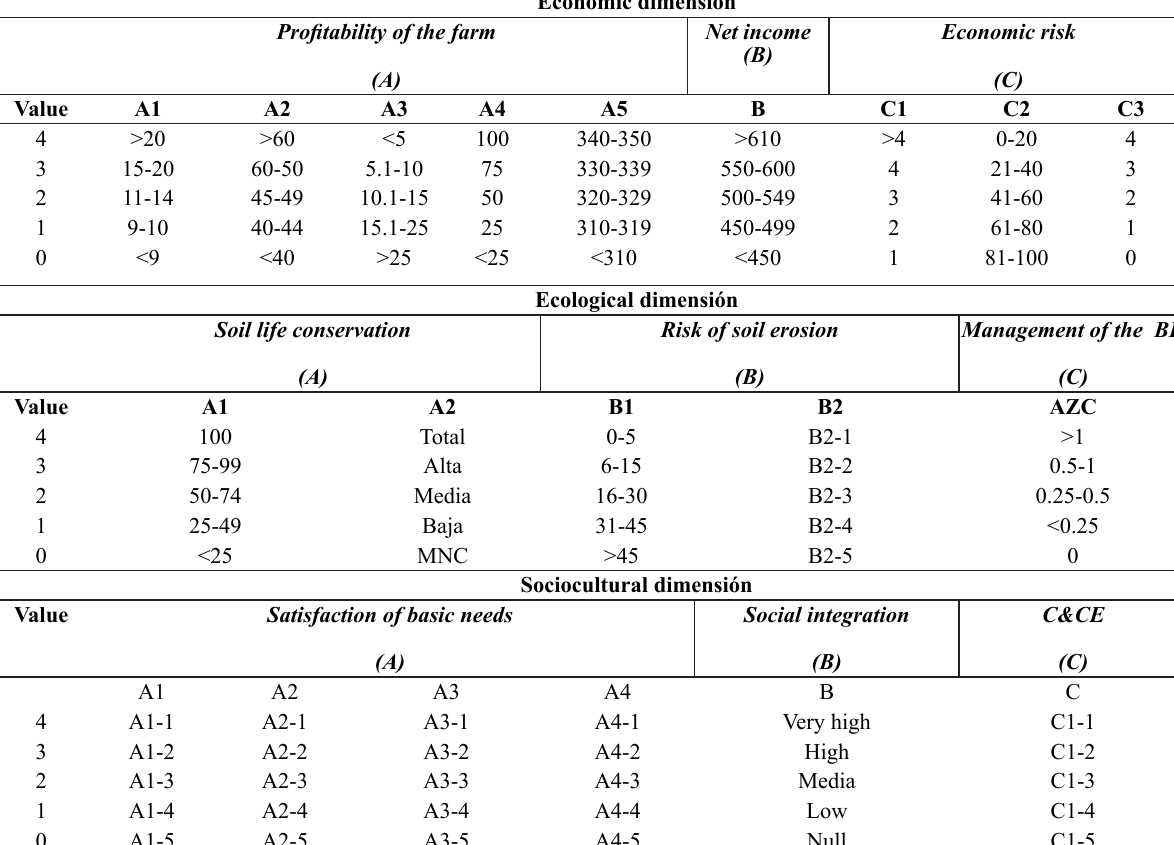
Table 1.- Sub-indicators and indicators used to evaluate the sustainability of lemon producing farms in Santa Elena,